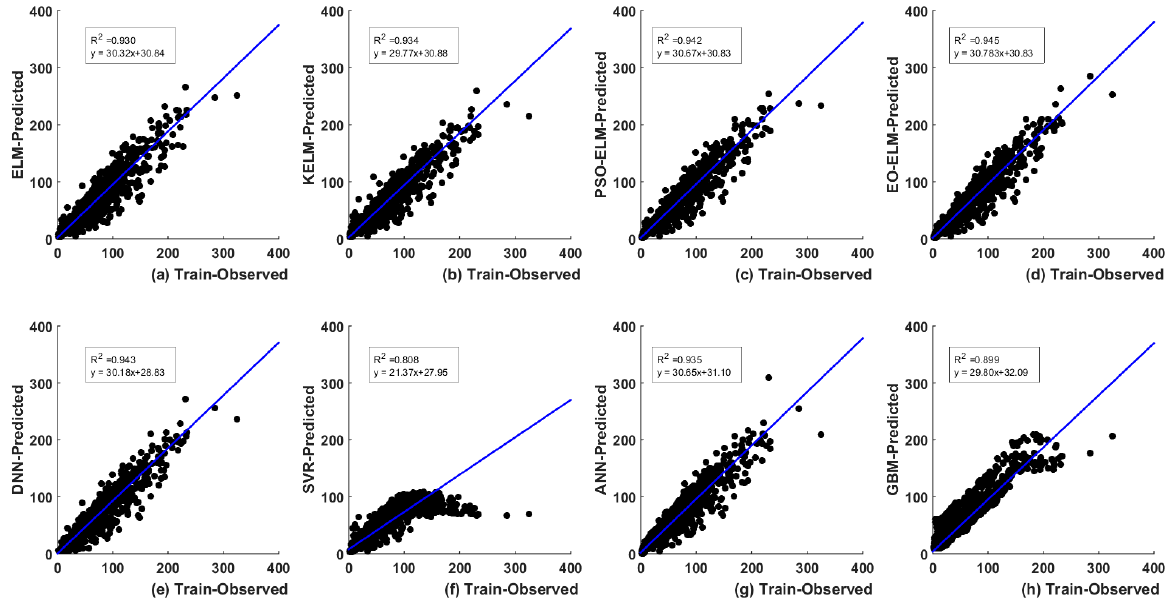
Figure 11. Prediction capability of the eight models in train case ( a ) ELM, ( b ) KELM, ( c ) PSO-ELM, ( d ) EO-ELM, ( e ) DNN, ( f ) SVR, ( g ) ANN, and ( h ) GBM for the catchment Teifi at Glanteifi.